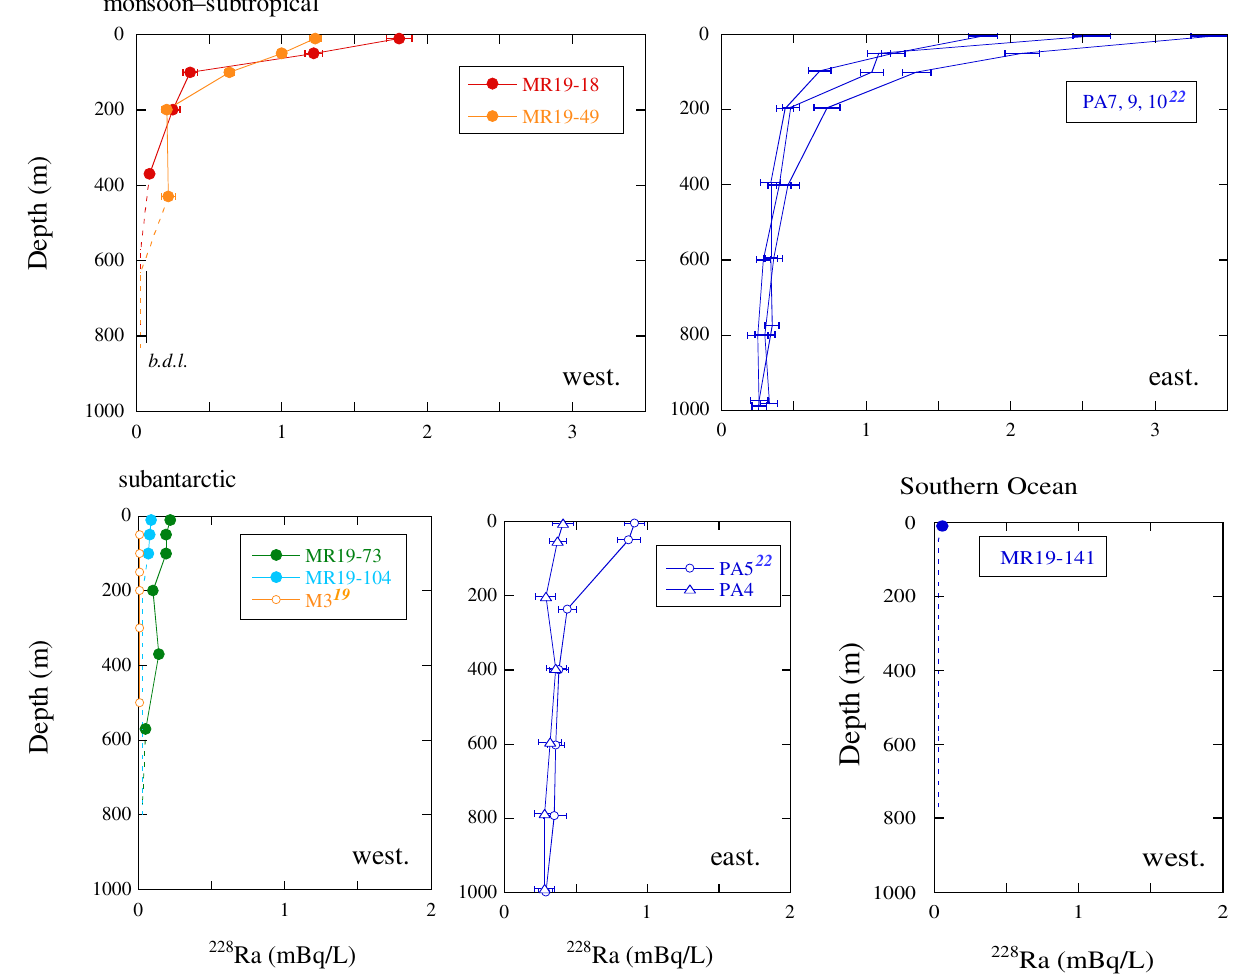
Figure 4. Vertical profiles of 228 Ra concentrations in the monsoon–subtropical and subantarctic areas in the Indian Ocean and the Southern Ocean, along with data from previous studies in each area 19,22